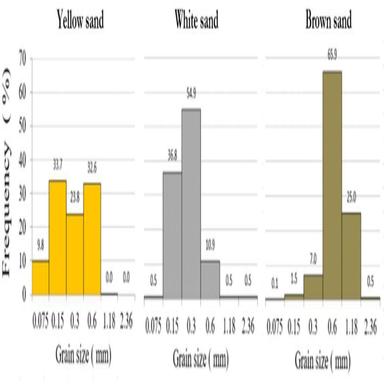
Histogram of the grain size distribution.